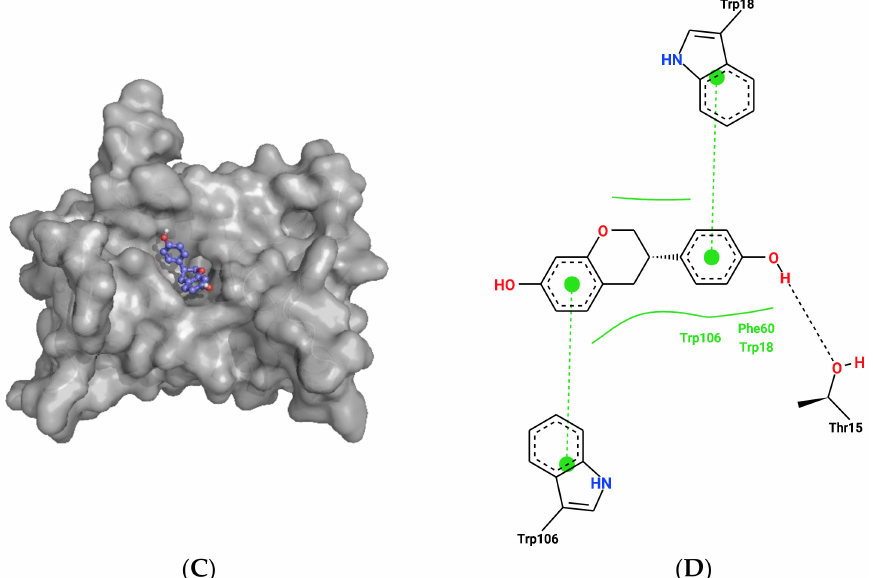
Figure 7. Docking results for ligand2995 to RAB4A and Equol to DERL1. The upper panel shows the docking results of ligand2995 to RAB4A (PDB 2BME). ( A ) Ligand2995 (coloured in purple) docked to RAB4A (PDB:2BME) crystal structure at the GTP (coloured in grey) biding site. ( B ) Two-dimensional representation of the binding pose of ligand2995 to RAB4A and predicted interactions between them. Black dashed lines represent hydrogen bonds, green spline sections show hydrophobic interactions and green dashed lines represent π - π stacking or π –cation interactions. ( C ): Equol (coloured in purple) docked to DERL1 (PDB:7CZB) crystal structure. ( D ) Two-dimensional representation of the binding pose of Equol to DERL1 and predicted interactions between them. Black dashed lines represent hydrogen bonds, green spline sections show hydrophobic interactions and green dashed lines represent π - π stacking or π –cation